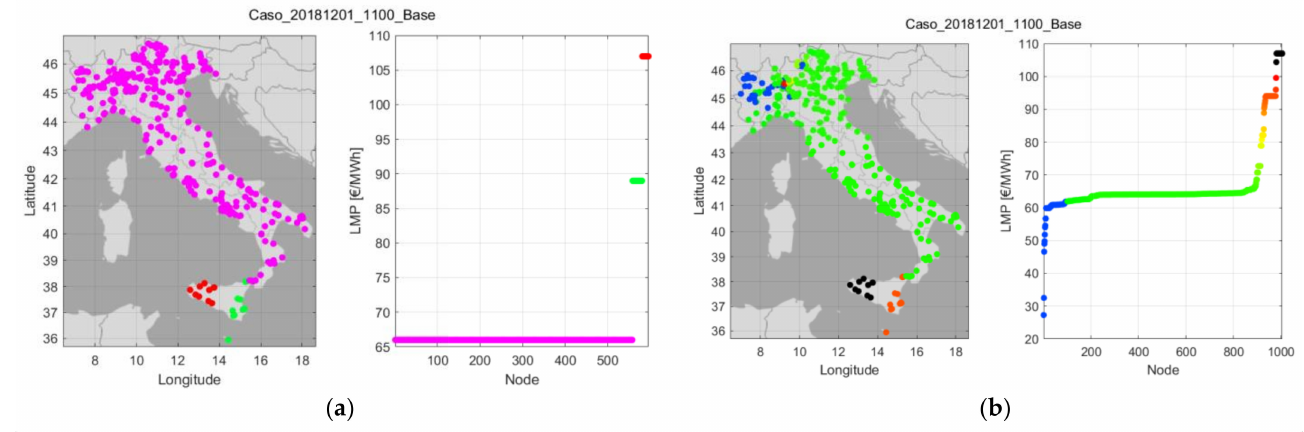
Figure 18. LMPs case 10.09.2018, 17:00, Base: ( a ) N1cor scenario; ( b ) N1cor scenario; ( c ) N70 scenario.